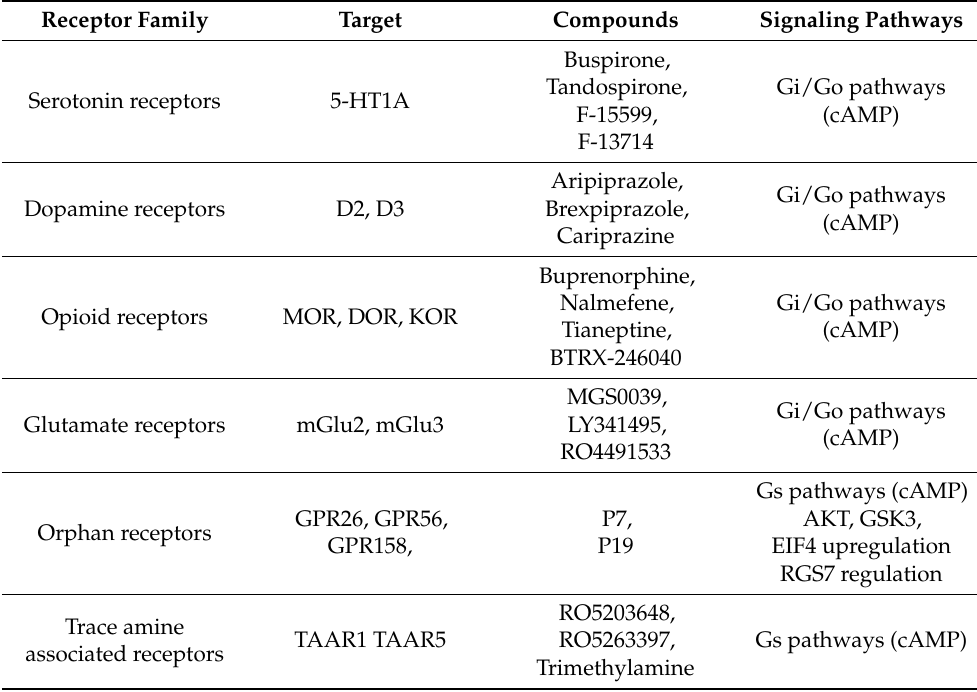
Table 1. GPCR targets, compounds with antidepressant activity, and signaling pathways activated by the target